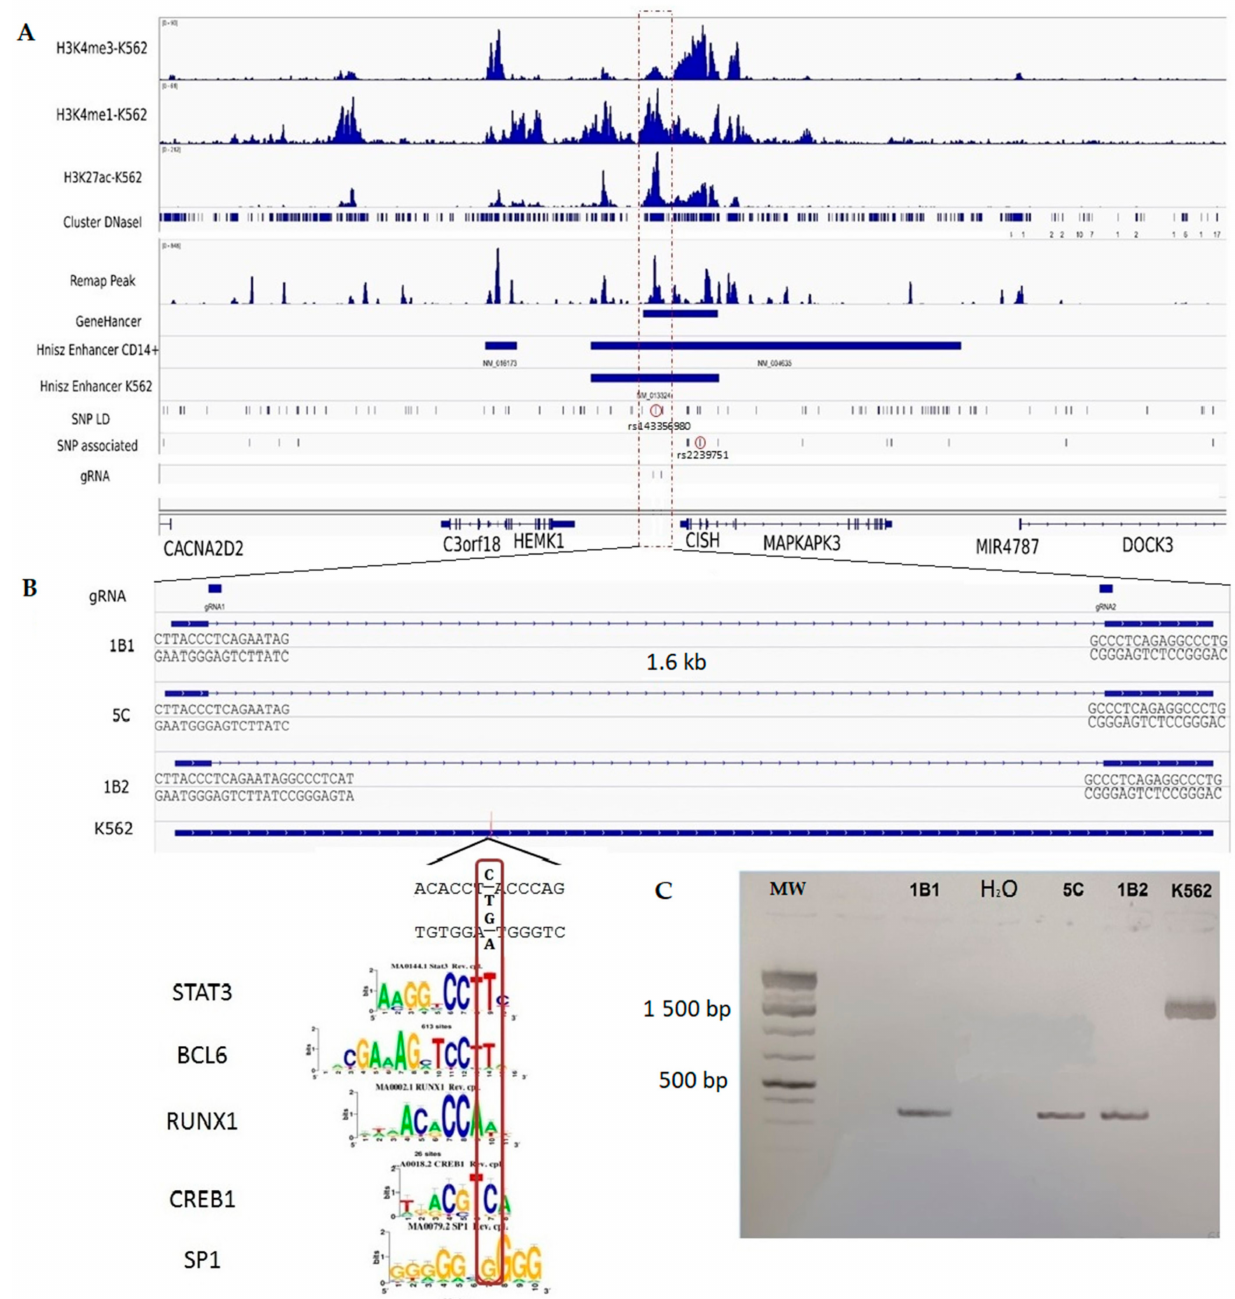
Figure 5. SNPs associated with mortality due to sepsis overlap enhancers in K562 cells and monocytes in the CISH - MAPKAPK3 gene locus. ( A ) Peaks of specific histone marks such as H3K4me3 (active promoters), H3K4me1, H3K27ac (active enhancers), and DNAse I hypersensitivity sites (open chromatin) are shown in K562 cells. Peaks of ChIP-seq for transcription factors from the Remap catalog, and location of enhancer predicted by GeneHancer and super-enhancer in CD14+ monocytes (Hnisz Enhancer CD14+) and in K562 cells (Hnisz Enhancer K562) are also indicated. The genomic position of the SNPs associated with mortality due to sepsis (SNP associated) and that of SNPs in linkage disequilibrium with them (SNP LD) is pointed out. Positions of guide RNA (gRNA) used to generate the deleted K562 cells (1B1, 5C, and 1B2) by CRISPR/Cas9 method are indicated. ( B ) Zoom on the region (framed in ( A )) containing rs143356980 in K562 WT cells and in 1B1, 5C, and 1B2 K562 deleted cells. Flanking sequences, and the motifs of transcription factors binding sites on the rs143356980 (red box) are specified. ( C ) PCR controls performed on the genomic DNA of WT K562 cells (K562) and in 1B1, 5C, and 1B2 deleted K562 cells using primers located upstream and downstream of the deleted region (MW, molecular